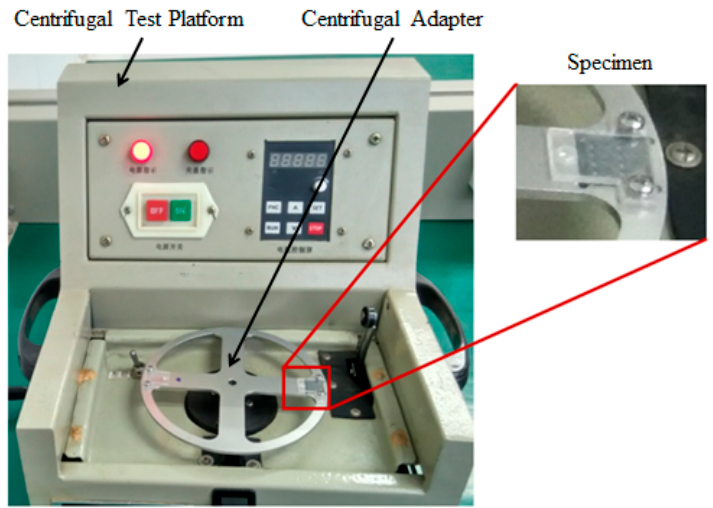
Figure 15. Centrifugal test platform and centrifugal adapter.